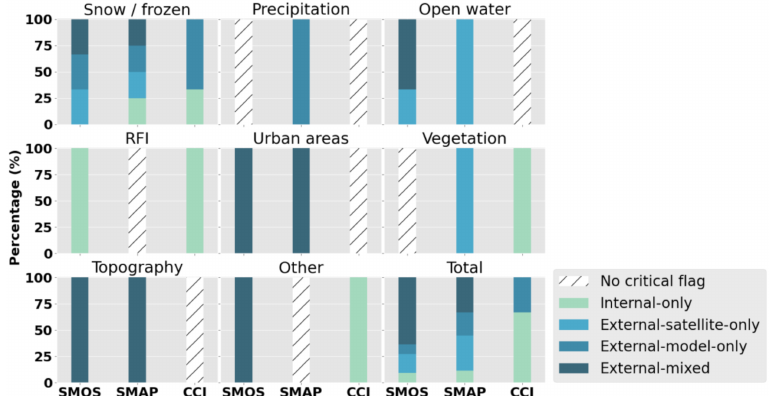
Figure 6. The percentage of data source types underlying the critical flags per flagging category for the sensor datasets SMOS and SMAP and the multi-sensor ESA CCI datasets. The green color denotes the internal satellite- only data source type and the blue colors the di ff erent external data source types (satellite-only, model-only, and